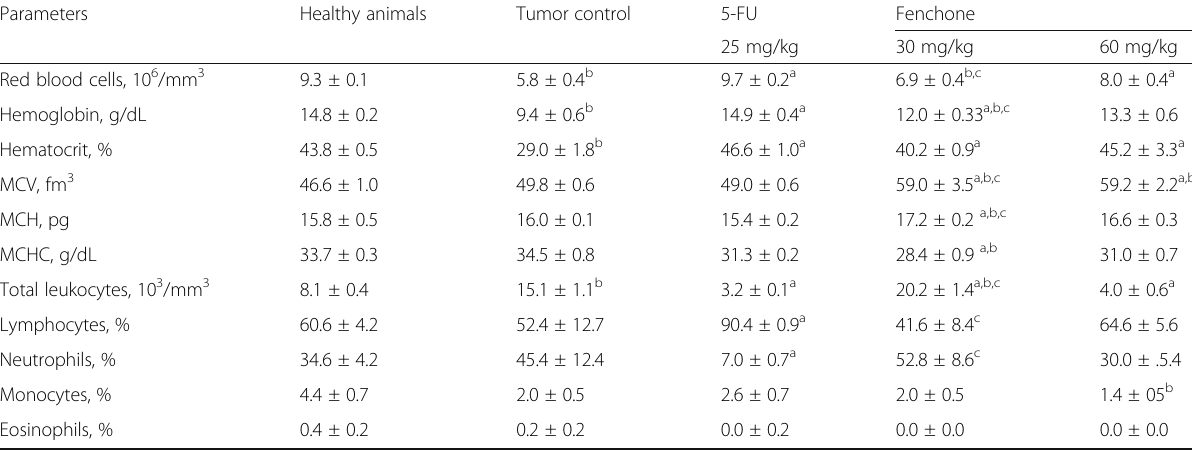
Table 9 Effects of fenchone and 5-FU on hematological parameters of peripheral blood of mice ( n =6) subjected to different treat- ments (9